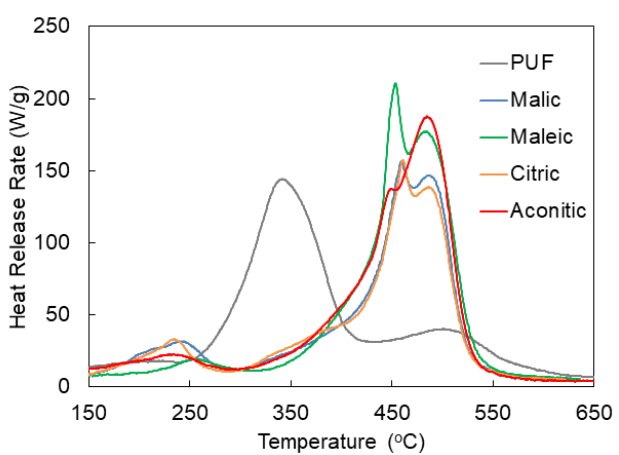
Figure 5. Representative microscale combustion calorimetry results for each foam sample. Table 2. Microscale combustion calorimetry parameters for each foam sample.